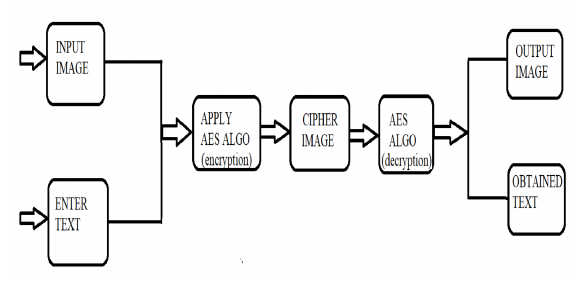
Figure 1. DATA HIDING PROCESS